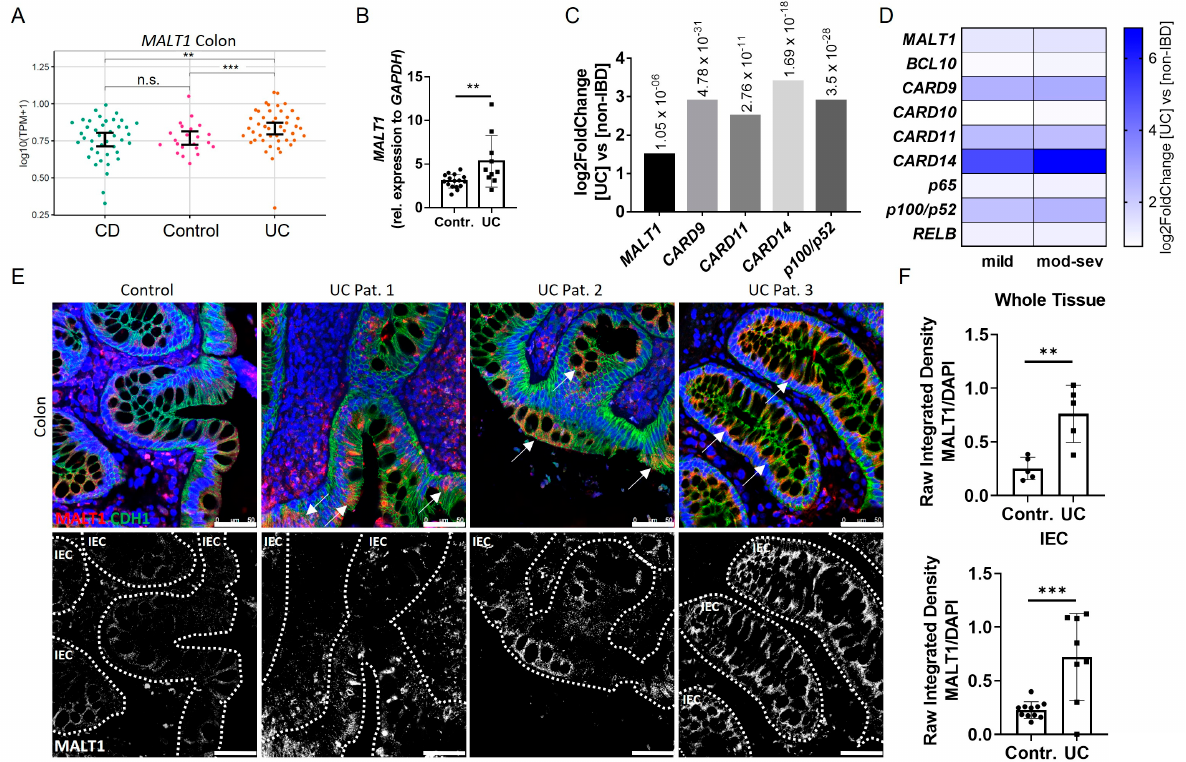
Figure 1. Increased intestinal epithelial MALT1 expression in UC patients. ( A ) RNA-seq expression levels of MALT1 in colon tissue samples derived from Crohn’s disease (CD) (n = 41) and ulcerative colitis (UC) (n = 46) patients and controls (n = 22). p values are derived from a two-tailed Wilcoxon test. Error bars represent 95% confidence intervals of the mean. ( B ) Quantitative real-time PCR of MALT1 mRNA expression levels in whole colon biopsies derived from control individuals (n = 16) and UC patients (n = 10). ** p < 0.01 in unpaired two-tailed t -test, error bars represent mean ± SD, 95% CI. ( C ) RNA-seq expression analysis of significantly altered CBM complex ( MALT1 , CARD9 , -11 , -14 ) and NF- κ B genes ( p100 / p52 ) in colon biopsies derived from treatment-naïve UC patients (n = 206) and non-IBD controls (n = 20). p values are indicated with the fold change. ANOVA for multiple comparisons, error bars represent mean ± SD, 95% CI. ( D ) RNA-seq expression analysis of CBM complex ( MALT1 , BCL10 , CARD9–11 , -14 ) and NF- κ B ( p65 , p100 / p52 , RELB ) genes in mild (n = 53) and moderate–severe (mod–sev, n = 152) in fl amed treatment-naïve UC patients and non-IBD controls (n = 20). ( E ) Representative images of colon cross sections from control individuals and UC patients immunohistochemically stained with antibodies against E-Cadherin (CDH1, green) and MALT1 (red), nuclei were counterstained with Hoechst 33342 (blue) (upper panel). High MALT1 expressing intestinal epithelial areas are indicated with arrows. Representation of MALT1 single channel (white), intestinal epithelial cells (IEC) are indicated with dashed lines (lower panel) (scale bar: 50 µm). ( F ) Quanti fi cation of MALT1 expression normalized to Hoechst intensity in whole colon tissue and IECs. n.s. (not signi fi cant), ** p < 0.01, *** p < 0.001 in unpaired two-tailed t -test, error bars represent mean ± SD, 95% CI.